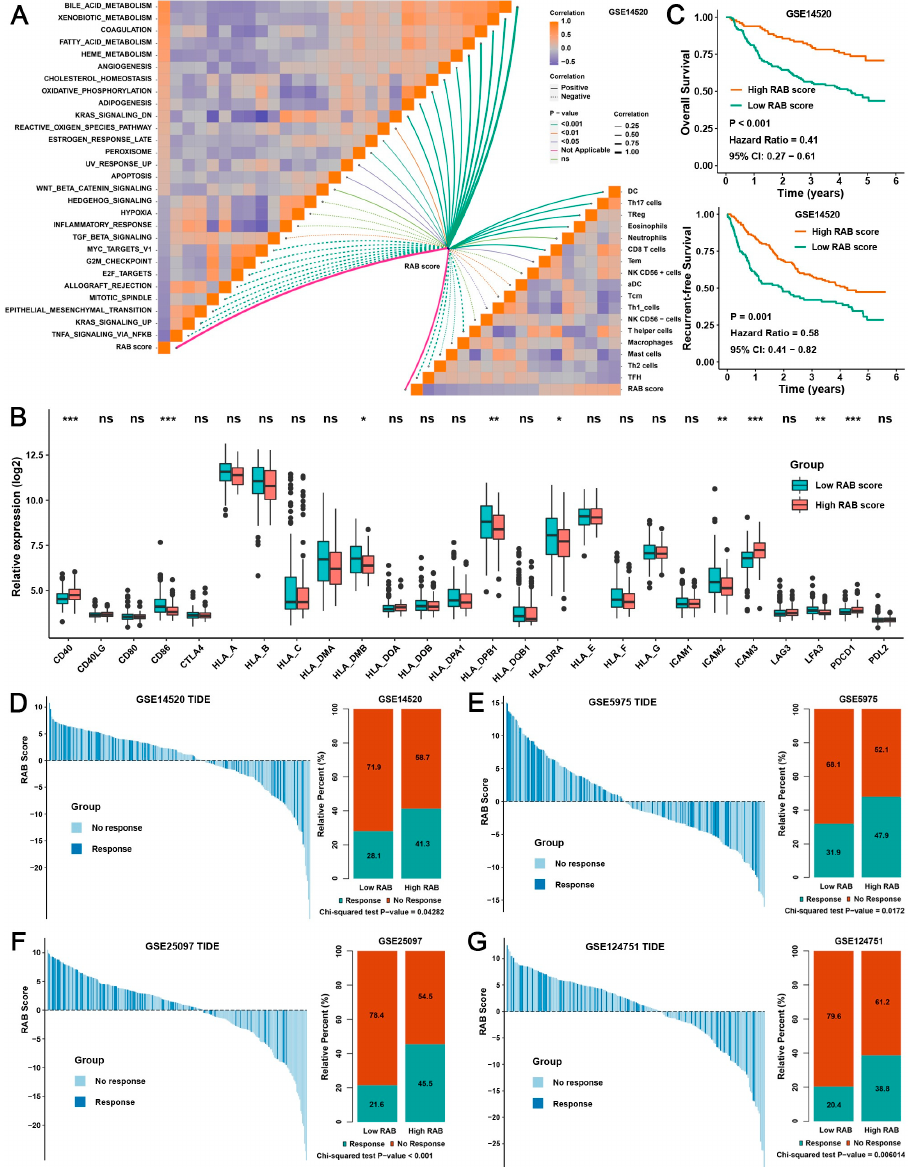
Figure 5. Validation of the RAB score for the immunotherapy response. ( A ) Correlation analysis of the RAB score with enriched signaling pathways from GSVA annotations (upper left panel) and previously published immune cell gene signatures (lower right panel) in the HCC cohort of GSE14520. ( B ) Differences in the expression of MHC molecules, costimulatory molecules, and adhesion molecules in distinct RAB subtypes of the HCC cohort from GSE14520. The upper and lower ends of the boxes represent the interquartile range of values. The lines in the boxes represent the median value, and the black dots show outliers. ( C ) Survival analyses for high- or low-RAB score groups of the HCC cohort of GSE14520. ( D – G ) TIDE values of the high- or low-RAB score groups of the HCC cohort from ( D ) GSE14520, ( E ) GSE5975, ( F ) GSE25097, and ( G ) GSE124751. The chi-square test was used to calculate significant differences. The asterisks represent the statistical p value (* p < 0.05, ** p < 0.01, and *** p < 0.001). ns, no